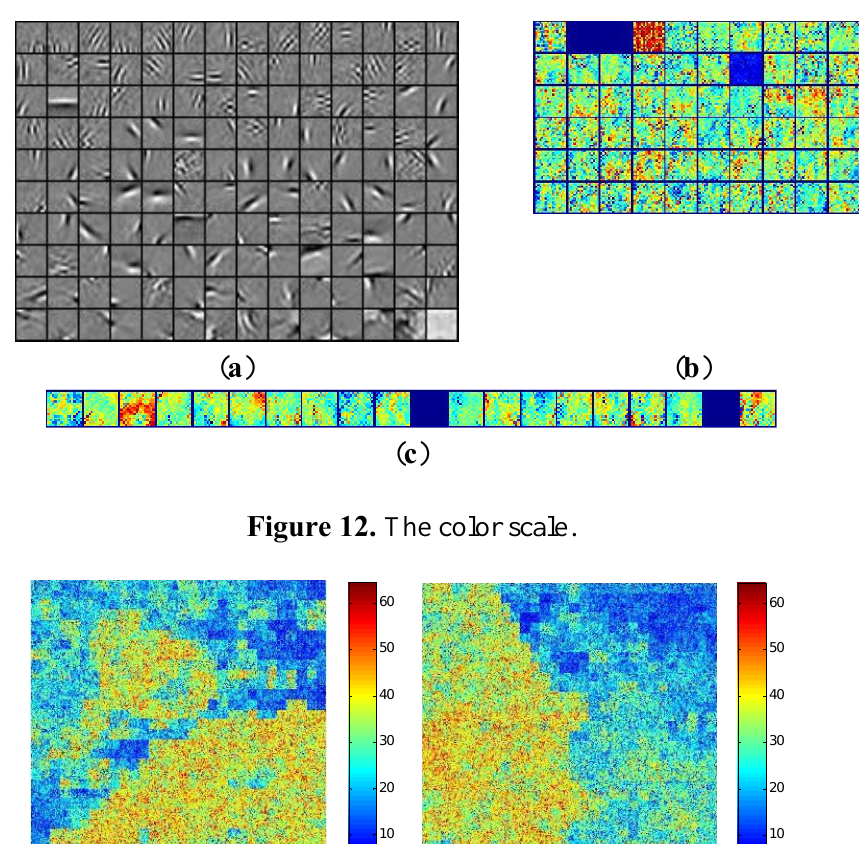
Figure 11. The basis functions. ( a ) Basis functions in the 1st layer; ( b ) Basis functions in the 2nd layer; ( c ) Basis functions in the 3nd